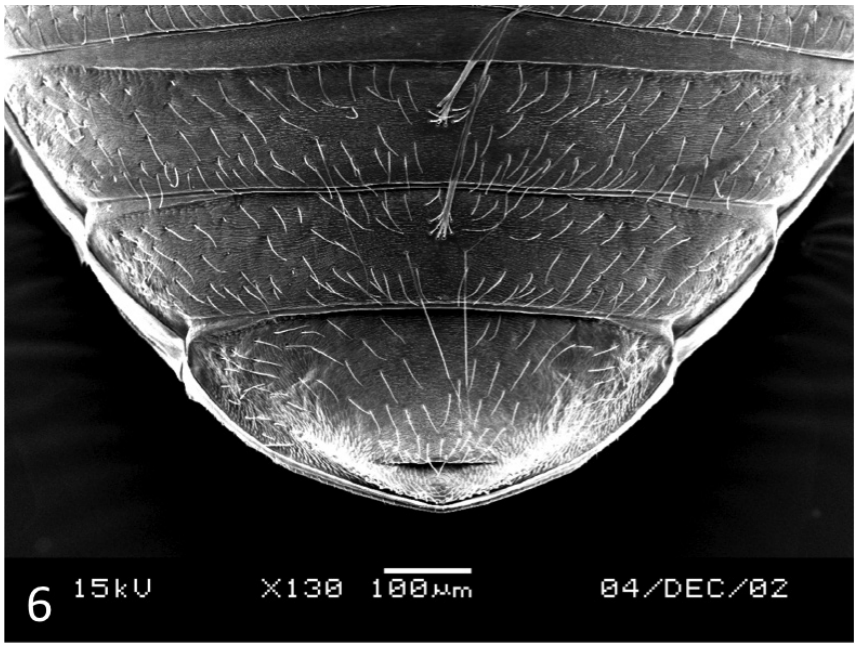
Figure 6. Leiodytes kualalipis sp. n.: female paratype, SEM of last ventrite with deep suture